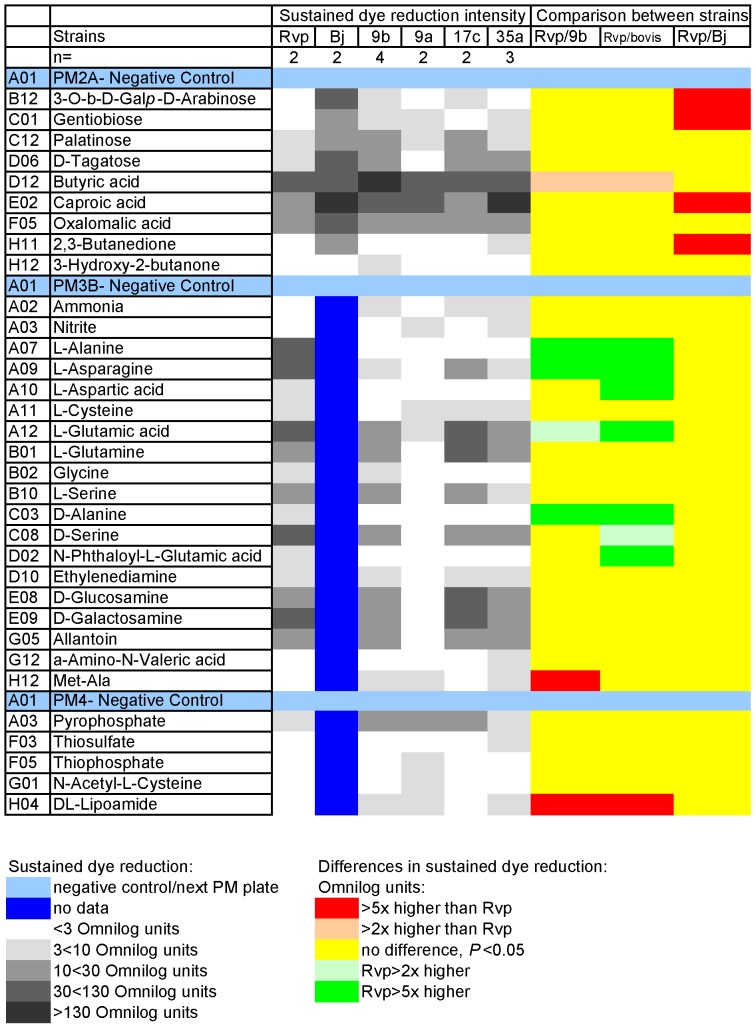
Carbon (plate PM2A), nitrogen (plate PM3B), phosphorous and sulphur sources (plate PM4A) giving sustained dye reduction, from 48 h reading to end (165 h), with carbon sources.n = Number of incubations (from separate pre-cultures). Code (corresponds with Table 1): Rvp = H37Rv (AHVLA); Bj = Bj 5208; 9a = type 9 61/0038/01; 9b = type 9 AF2122/97; 17c = type 17 21/7917/05; 35a = type 35 61/1307/01. Cut off for +ve is 3, the median value for well PM01, A03, since we confirmed substrate use as a C-source by growing in culture flasks using it. a3-O-β-D-Galactopyranosyl-D-Arabinose. Not rejected, but there's a risk the D-ara is released and abiotic dye reduction follows; baccepted, possible trace in a single strain.